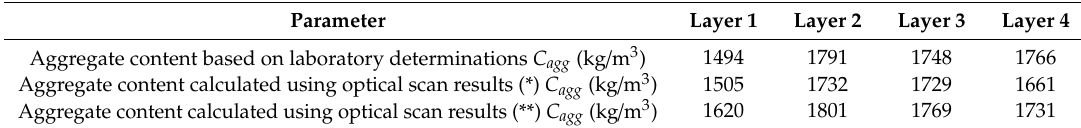
Table 6. Comparison of results (aggregate